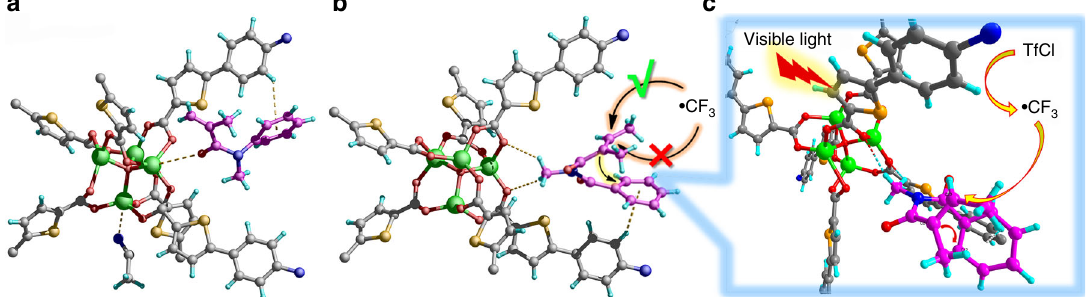
Fig. 7 Illustration of the interactions between the encapsulated substrates and Zn – TCTA . a Structure of 3a @Zn – TCTA . b Structure of 3f @Zn – TCTA . c The plausible mechanistic interpretation of the role of substrate encapsulation in diastereocontrol Solid-state cyclic voltammograms were measured using a carbon-paste working electrode; a well-ground mixture of each bulk sample and carbon paste (graphite and mineral oil) was set in the channel of a glass tube and connected to a copper wire. A platinum-wire counter electrode and an Ag/AgCl reference electrode were used in an aqueous solution of KNO 3 . The solid fl uorescent spectrum were measured on an Edinburgh FS920 instrument. The time-resolved luminescence spectrum were measured on an Edinburgh FLS920 spectrometer.